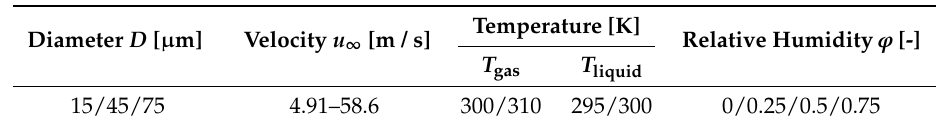
Table 2. Parameter range for DNSs.